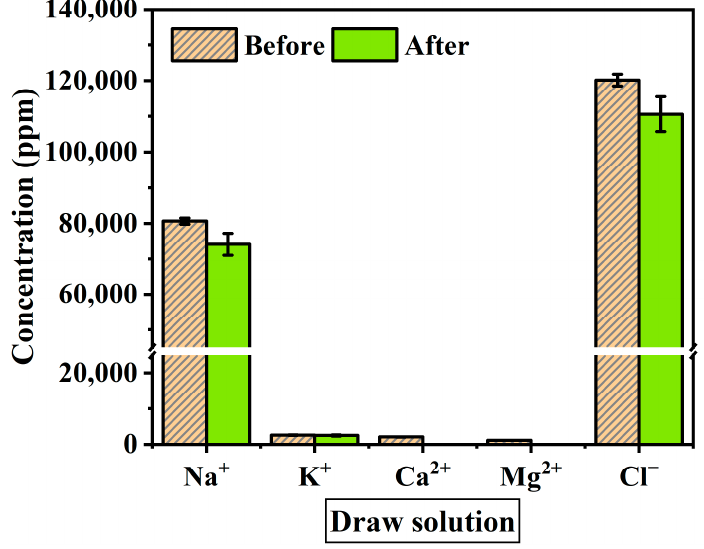
Figure 7. Average ion concentration of draw solution before and after the experiment. The experimental conditions are the FO process (flow rate: 200–500 mL/min) and PAFO process (0.5–1.5 conditions are the FO process (flow rate: 200–500 mL / min) and PAFO process (0.5–1.5 bar) in AL-FS bar) in AL-FS mode and AL-DS mode. Operating time: 1 h; System temperature: 36.5 ± 0.5 °C. mode and AL-DS mode. Operating time: 1 h; System temperature: 36.5 ± 0.5 ◦